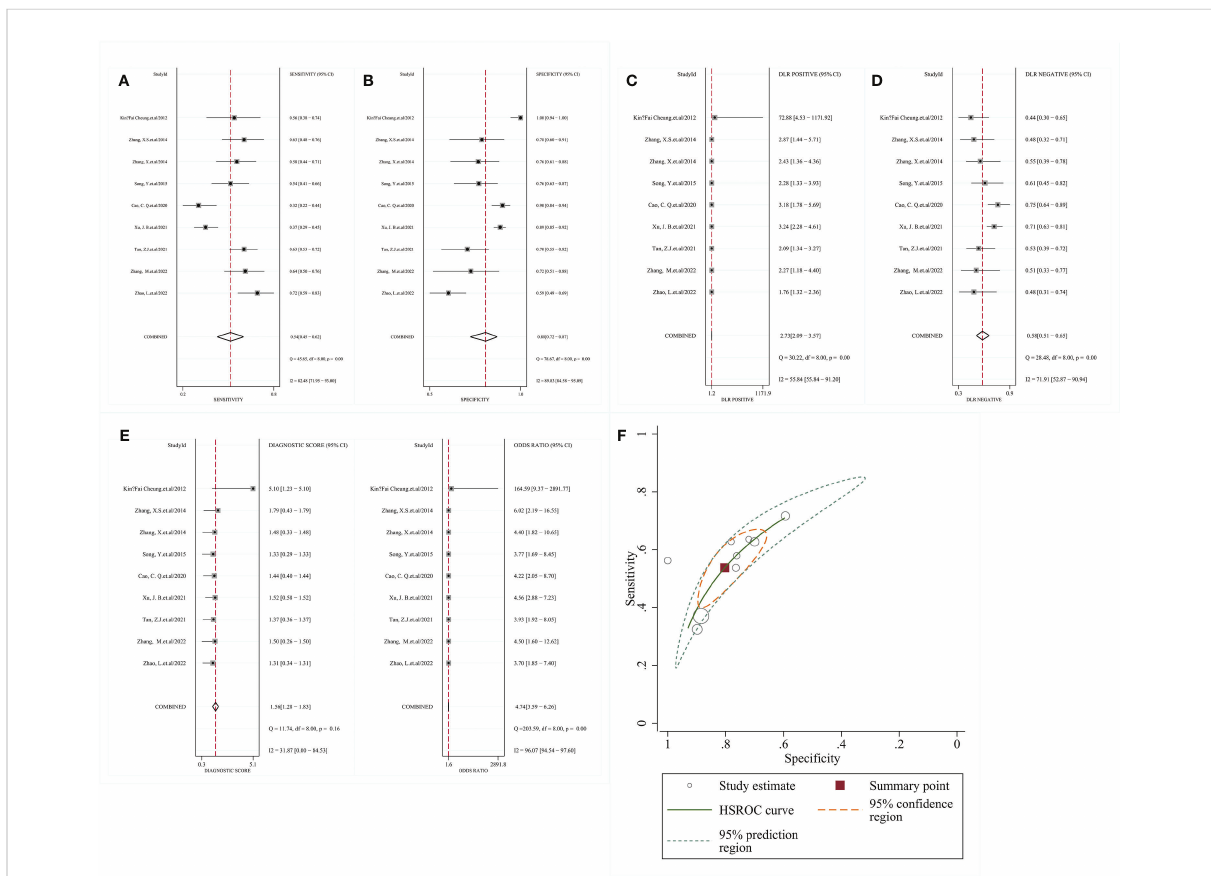
FIGURE 3 Meta-analysis results of RNF180 methylation for the diagnosis of gastric cancer (A) sensitivity; (B) speci fi city; (C) PLR; (D) NLR; (E) DOR; (F) HSROC; PLR, positive likelihood ratio; NLR, negative likelihood ratio; DOR, diagnostic odds. ratio; HSROC, hierarchical summary receives operating